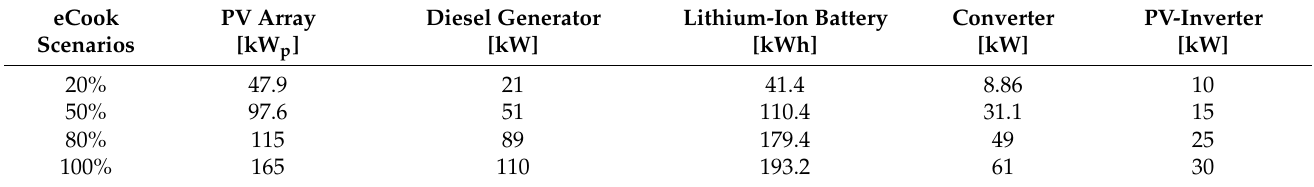
Table 5. Component sizes for eCook mini-grid deployment scenarios (without considering 1.2 DC/AC ratio). eCook Scenarios